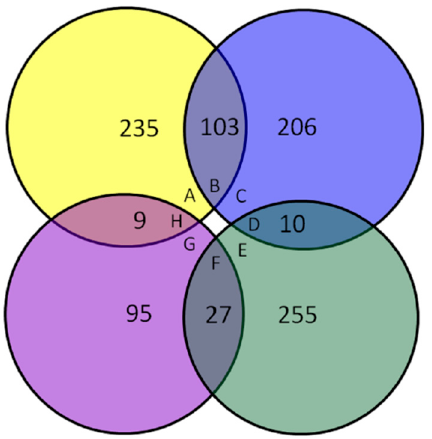
Figure 4. Statistical analysis of differentially expressed proteins (DEPs): A—Numbers of DEPs up-regulated only in the IADN/COSMN group; B—Numbers of DEPs up-regulated both in the